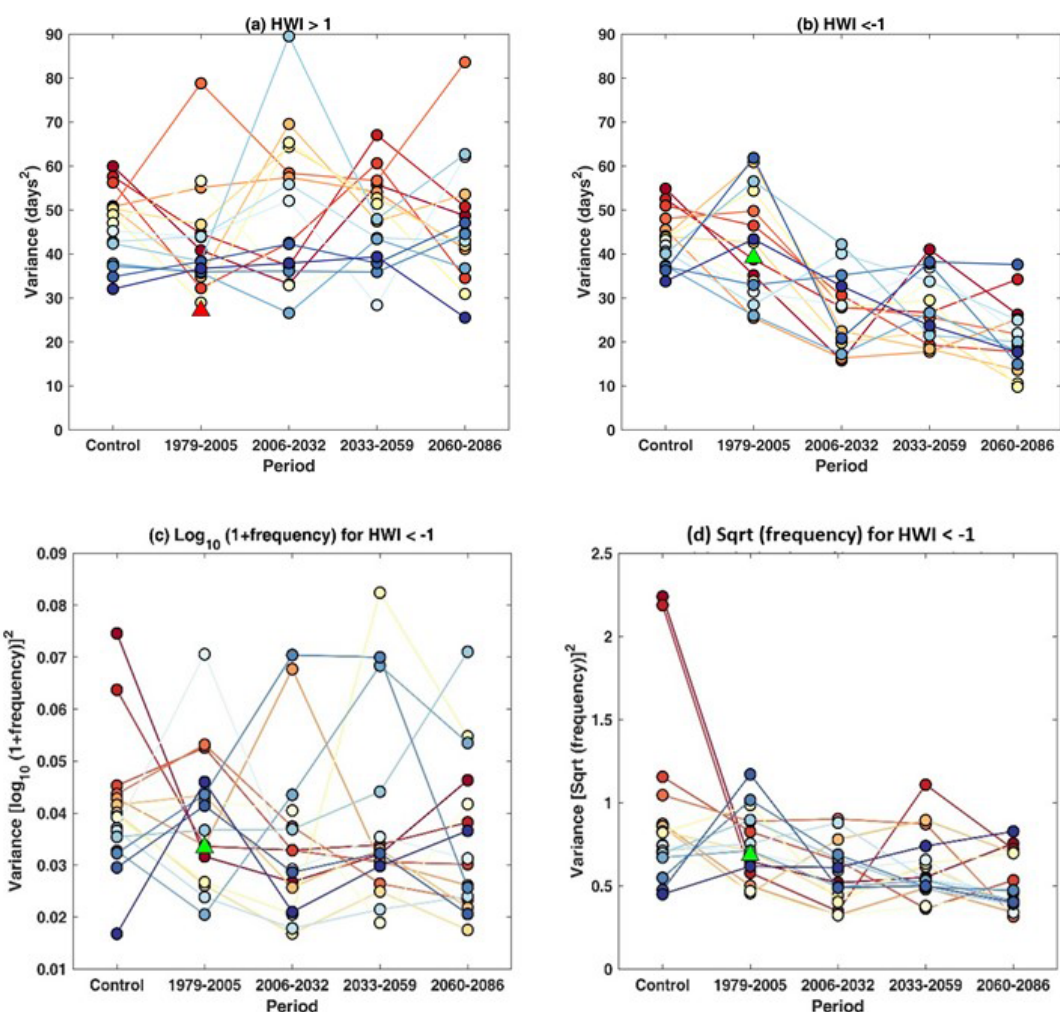
Figure 9. Interannual variances in the frequencies of winter (a) haze-conducive weather (HWI > 1) and (b) clear weather (HWI < − 1) for the control simulation and the historical (1979–2005), near-future (2006–2032), mid-future (2033–2059), and far-future (2060–2086) periods under RCP8.5 for all 16 PPE members. Coloured circles are plotted for individual PPE members and triangles for the ERA-5 data. Panels (c, d) are same as (b) but with log 10 and square-root power transformations. For (c) and (d) , we first calculated the log 10 of (1 + frequency) and the square root of the frequency of clear days for the control simulation and each time period, and then we estimated the variance for each respective period. The lengths of the control simulation and all future periods are the same as that of the historical period, i.e. 27 years. The 27 years used for the control here were randomly selected from a 170-year control simulation for each